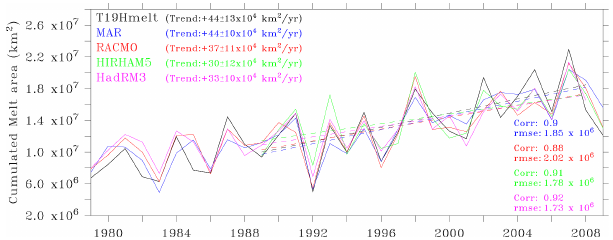
Fig. 6. Time series of annual total ice sheet melt extent from the RCMs and from the satellite data via the T19Hmelt algorithm. Total melt extent is defined as annual total sum of daily ice sheet melt area. ERA-40 forced simulations are used before 1989, and ERA- Interim-forced